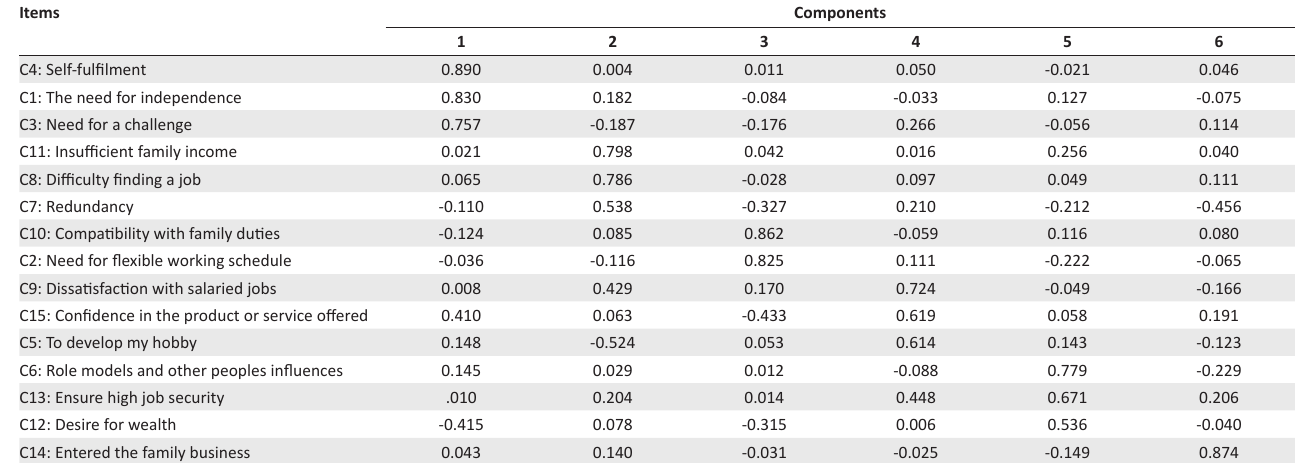
TABLE 5: Varimax-rotated component matrix: Motivation to start a business.